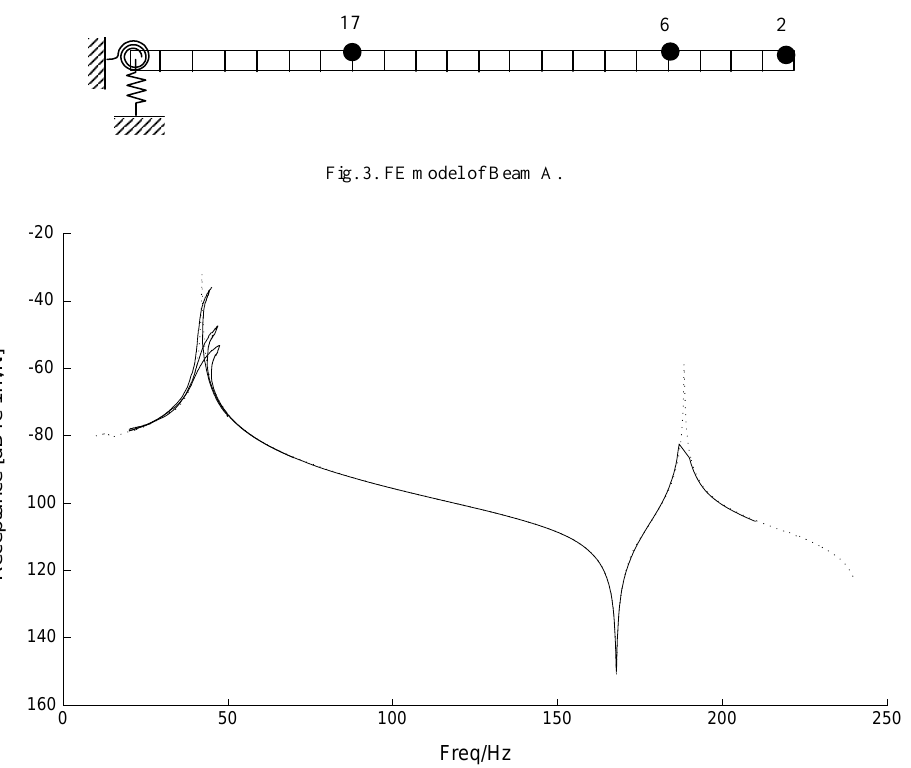
Fig. 4. Non-linear and linearised responses: Measured non-linear response, ... Low-excitation (linearised)